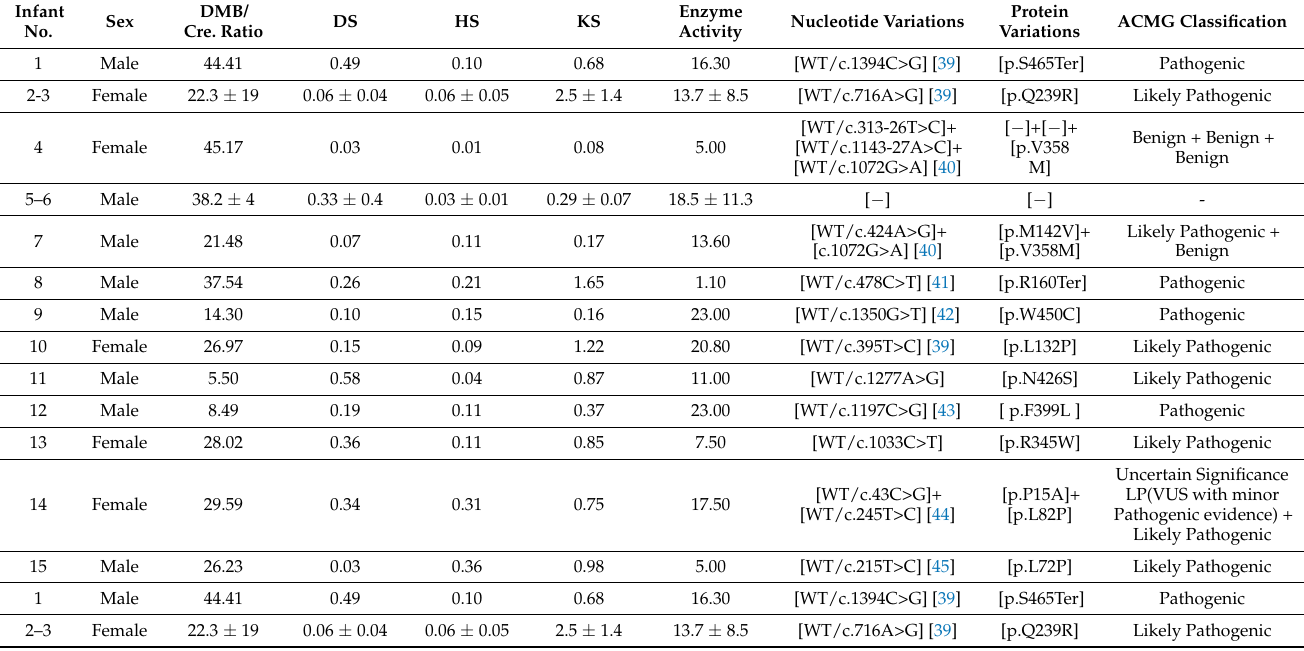
Table 4. Biochemistry tests, enzyme activity, and mutations of Arylsulfatase B (ARSB) gene in suspected MPS VI infants. Infant No.